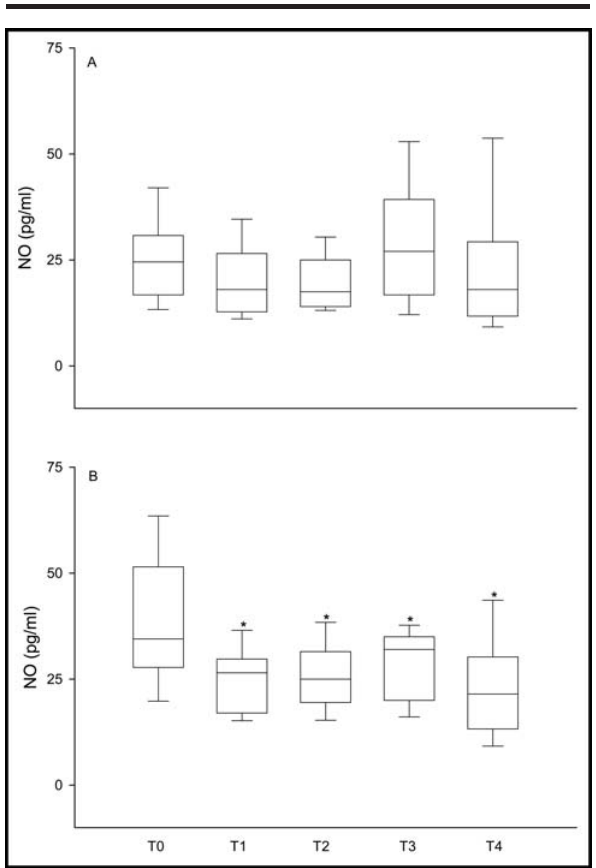
FIGURE 4 - Plasma nitrite plus nitrate concentrations during and after bypass. Patients